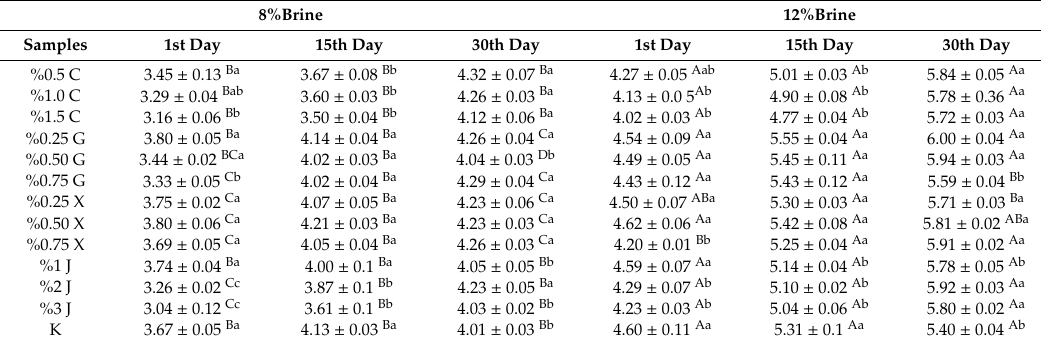
Table 3. Salt content (%) of cheese samples during